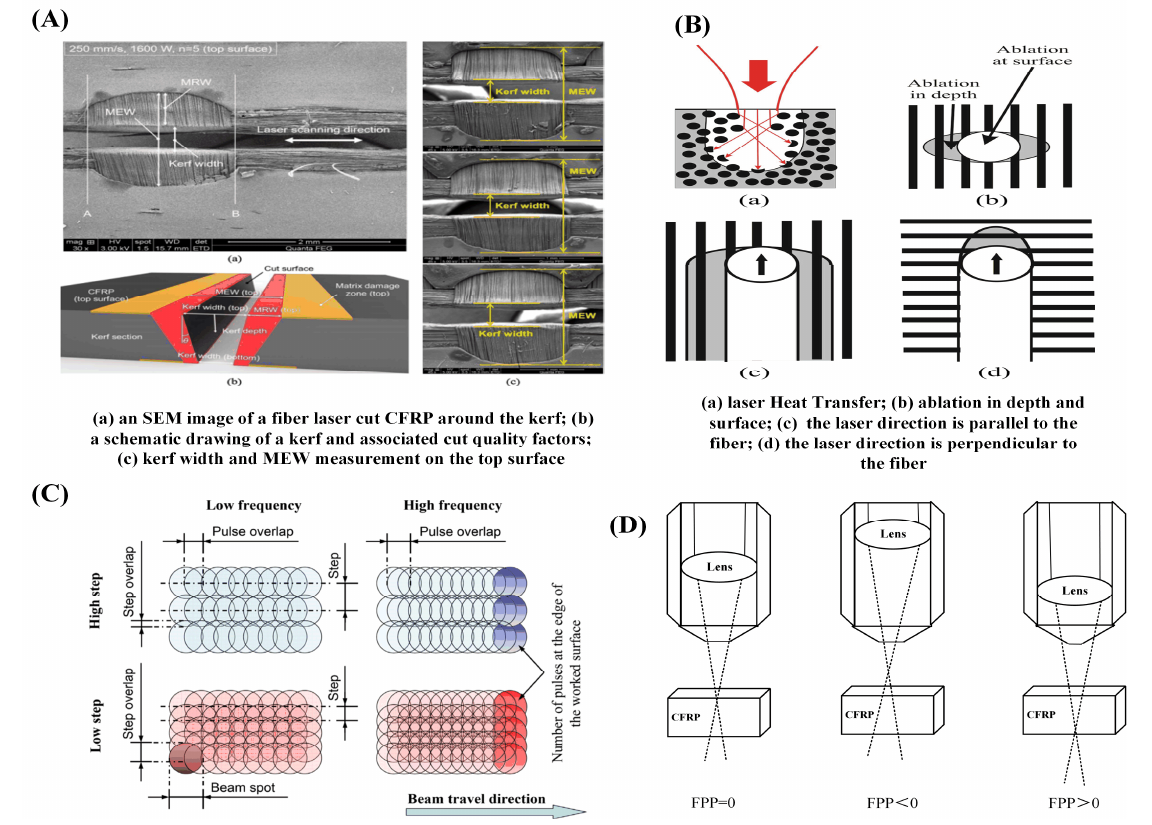
Figure 11. Schematic diagram of the effect of laser process parameters on the processing of CFRP in laser processing: ( A ) effect of laser processing parameters on CFRP [69]; ( B ) schematic diagram of the different scanning directions of the laser [73]; ( C ) graph of scanning speed versus repetition frequency [37]; ( D ) different out-of-focus situations for laser processing.